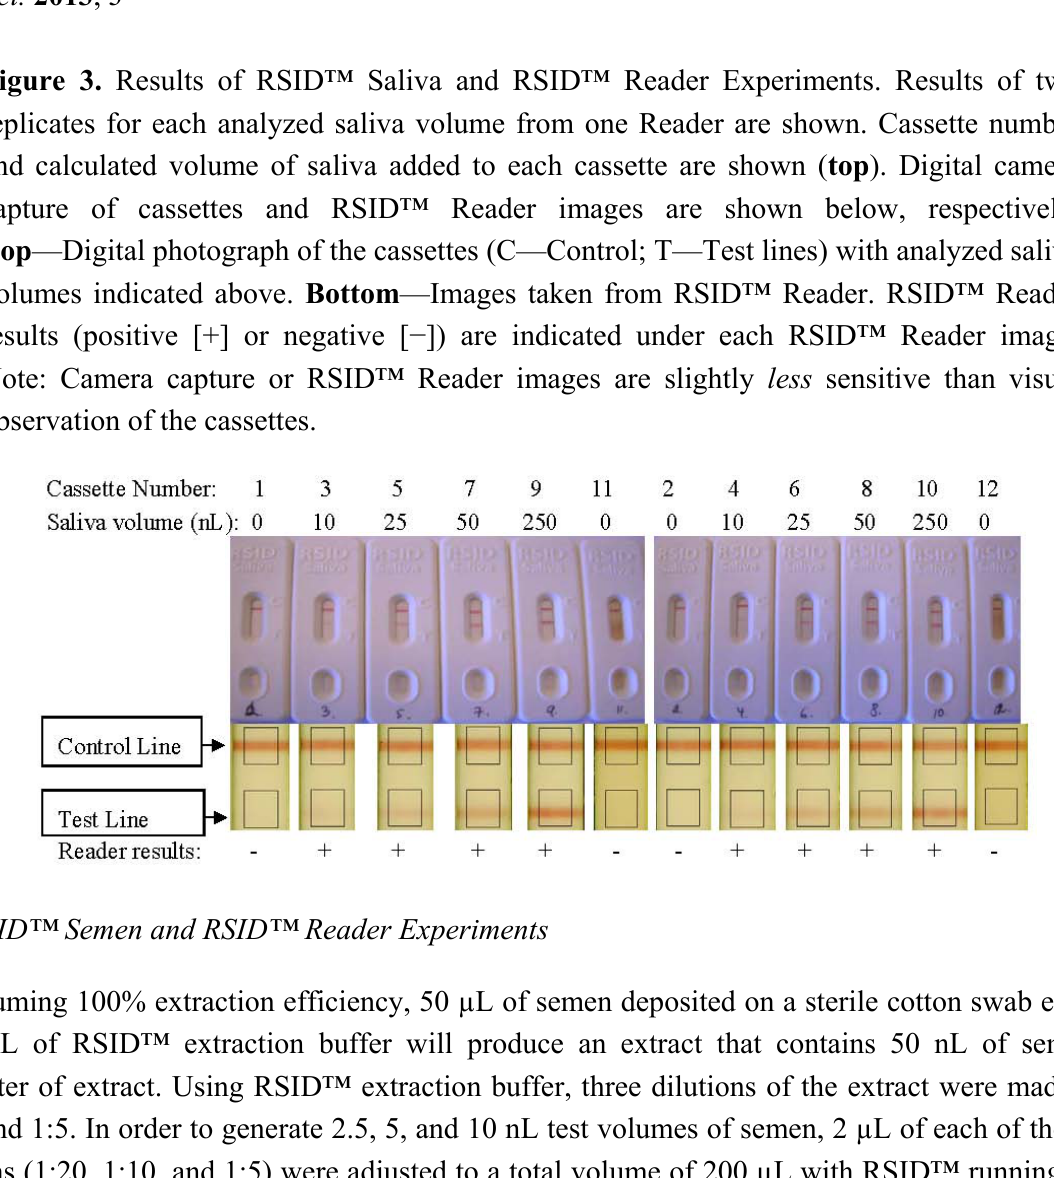
Figure 3. Results of RSID™ Saliva and RSID™ Reader Experiments. Results of two replicates for each analyzed saliva volume from one Reader are shown. Cassette number and calculated volume of saliva added to each cassette are shown ( top ). Digital camera capture of cassettes and RSID™ Reader images are shown below,